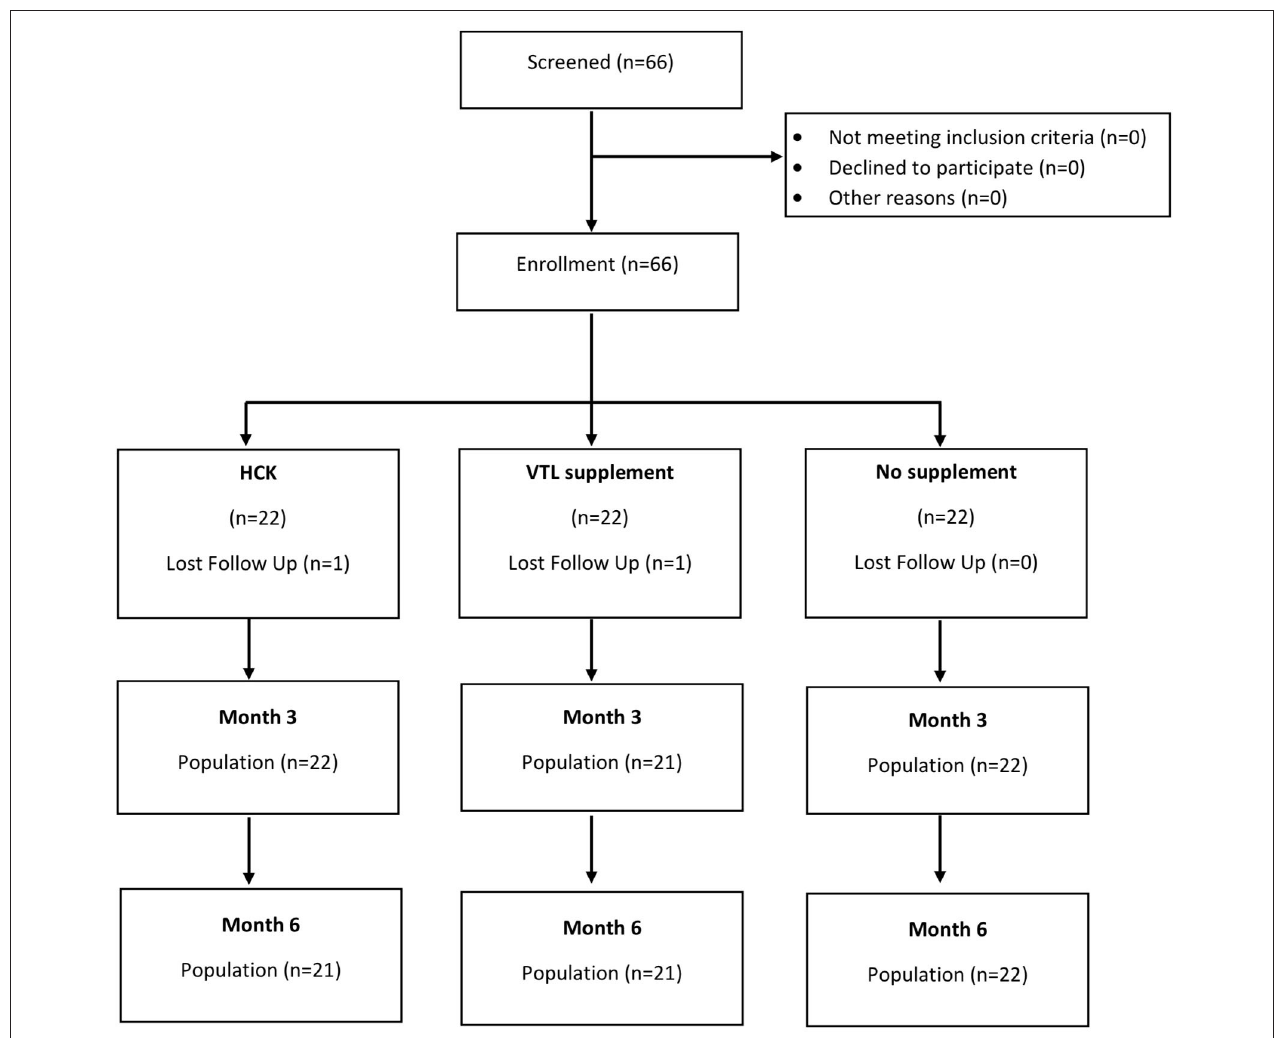
FIGURE 1 | Patient